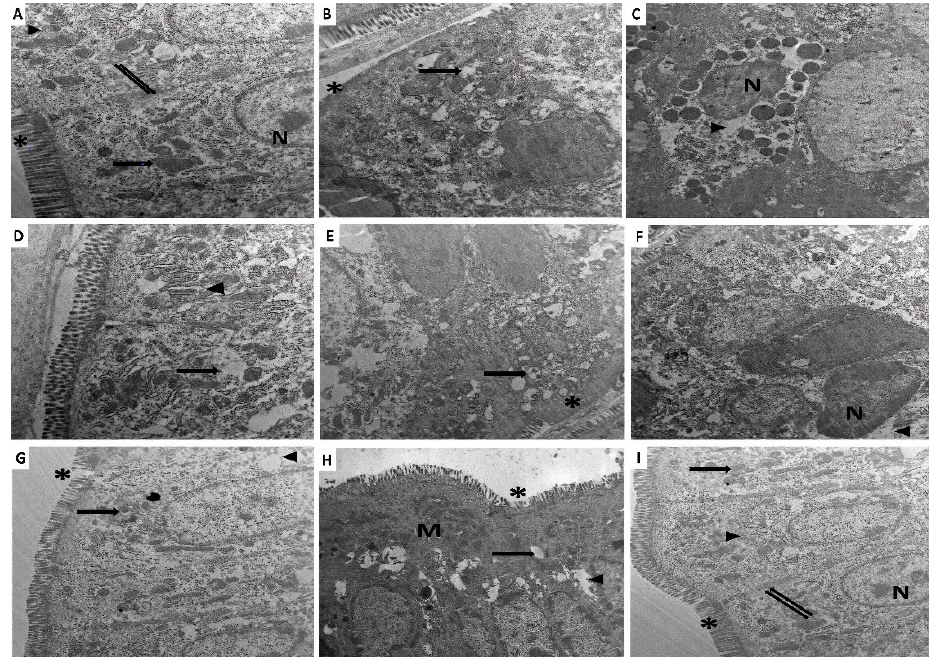
Figure 8. A transmission electron micrograph of a part of the colon of ( A ) The control untreated group showing absorptive columnar cells with apical microvilli (Asterisk), junctional complexes (Double arrows), mitochondria (Arrow), RER (Arrow head) and nuclei with prominent nucleoli (N) (×3000); ( B ) DSS mice exhibiting evident loss of the microvilli (Asterisk) and swollen mitochondria with destructed cristae (Arrow) (×3000); ( C ) DSS mice showing perinuclear cytoplasmic vacuola- tions (Arrow head) with hyperchromatic shrunken compressed nucleus (N) (×1500); ( D ) DSS mice exhibiting marked dilatation of RER (Arrow head) and marked cytoplasmic vacuolations (Arrow) (×3000); ( E ) DSS mice treated with CMC showing loss of the apical microvilli (Asterisk) and swollen mitochondria with destructed cristae (Arrow) (×2000); ( F ) DSS mice treated with CMC exhibiting perinuclear cytoplasmic vacuolations (Arrow head) and hyperchromatic shrunken compressed nu- cleus (N) (×3000); ( G ) DSS mice treated with perindopril showing partial loss of the apical microvilli (Asterisk), mild cytoplasmic vacuolation (Arrow head) and preserved normal mitochondria with scanty areas of mitochondrial swelling and destructed cristae (Arrow) (×2000); ( H ) DSS mice treated with ambrosin revealing nearly normal apical microvilli (Asterisk), cytoplasmic vacuolation (Arrow head) and preserved normal mitochondria (M) with scattered areas of mitochondrial swelling with destructed cristae (Arrow) (×2000); ( I ) DSS mice treated with perindopril/ambrosin combination showing apparently normal columnar cells with apical microvilli (Asterisk), RER (Arrow head), in- tercellular junctions (Double arrows), mitochondria (Arrow) and nucleus (N) (×2000). 4. Discussion Ulcerative colitis is a chronic non-specific inflammatory disease primarily affecting the mucosa and submucosa of the colon [26]. The etiological factors underlying the inci- dence of this disorder are still not completely explored [27]. Nevertheless, alteration of the gut microflora, enhanced generation of pro-inflammatory cytokines, overproduction of ROS, and modulation of autophagy/apoptosis balance were suggested as potential con- tributing factors [28]. The effect of these factors on the progression of ulcerative colitis was